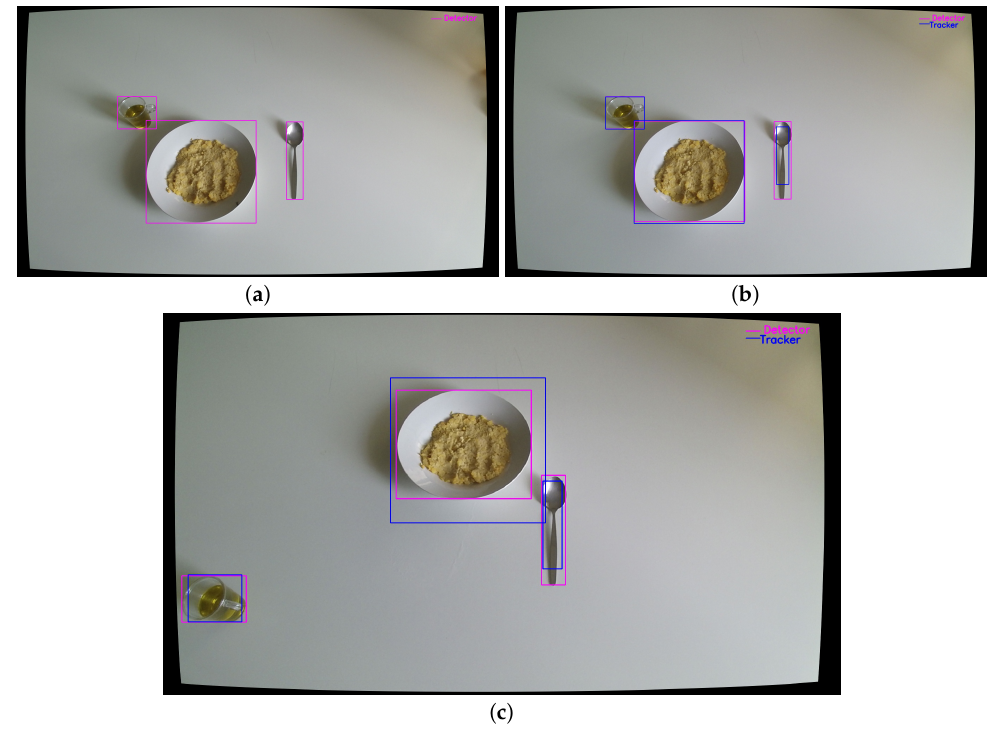
Figure 5. Showcase of simultaneous object detection and tracking: ( a ) solely object detec- tion, ( b ) combination of object detection and tracking, ( c ) updated detection and